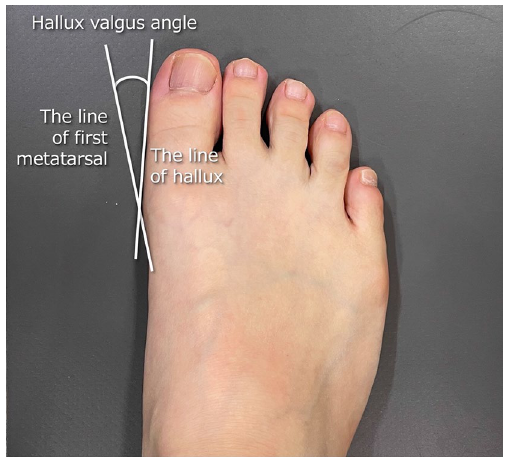
Figure 1. Methodology for determining the hallux valgus angle. This angle was calculated as the angle between the medial aspect of the hallux and first metatarsal on an image taken in the horizontal plane from the height of the participant’s